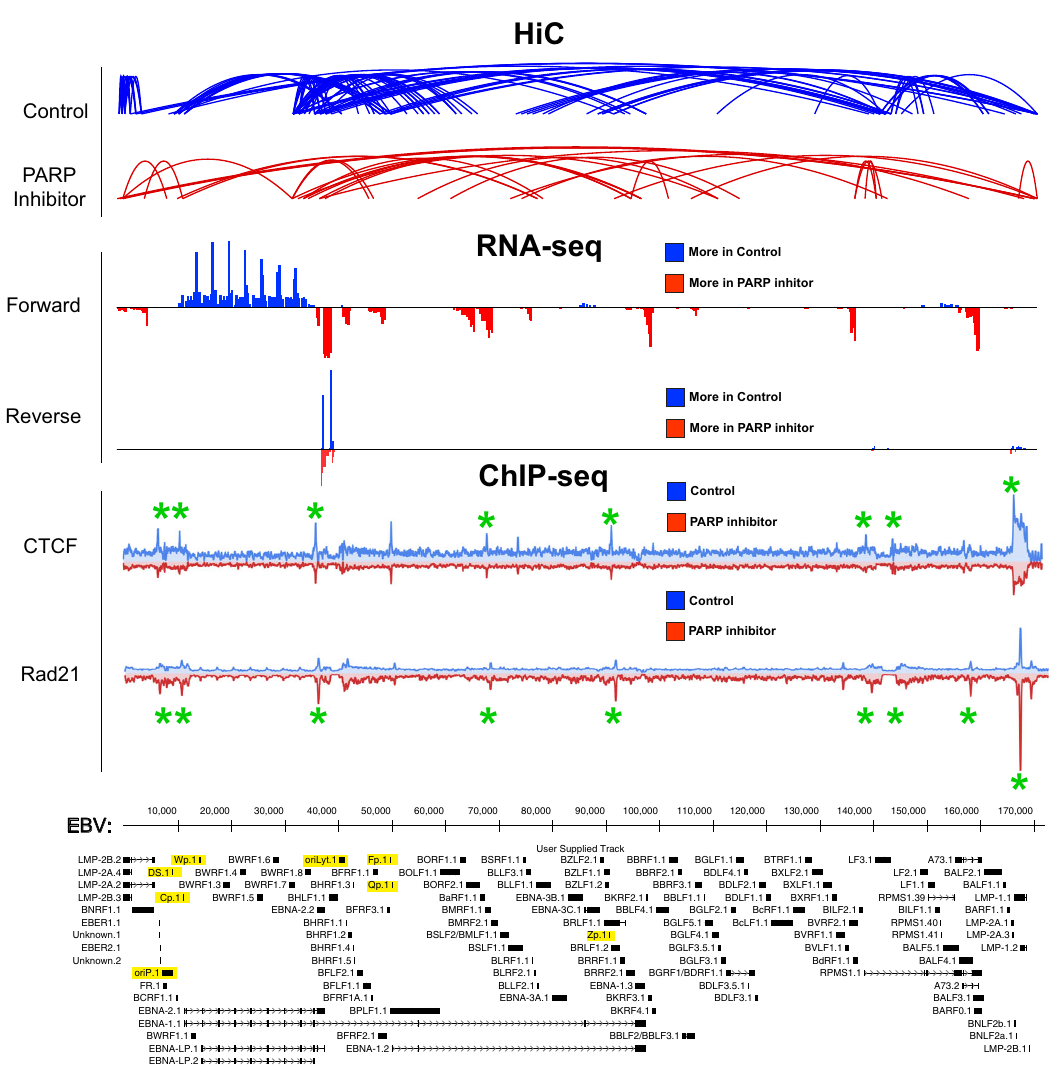
Fig. 4 HiC, ChIP-seq, and RNA-seq aligned datasets. The top panel “ HiC analysis ” aligns differences in chromatin looping between control and 2.5 µ M olaparib treated LCLs to the EBV genome. Blue arcs represent chromatin loops that are more frequent in the control genome, red arcs represent chromatin loops that are more frequently observed in the olaparib treated genome, and black arcs are loops that are unchanged between control and treatment. All arcs represent DNA-DNA interactions that occur at a statical signi fi cance of p < 0.05 from averaged biological duplicates. The middle panel “ RNA-seq ” displays RNA reads, forward and reverse, aligned to the EBV genome. Blue peaks pointing upward represent reads that occur more frequently in control LCLs while Red peaks pointing downwards represent reads occurring more frequently in olaparib treated LCLs. Genes with 2-fold change and q < 0.01 after correction for multiple testing (FDR) were considered as signi fi cantly differentially expressed. Bottom panel “ ChIP-seq ” aligns CTCF and cohesin (RAD21) tracks to the EBV genome, with and without PARP inhibition (2.5uM olaparib treatment for 72 h). The blue peaks pointing upwards represent regions of chromatin where CTCF or RAD21 binds more frequently in control samples while the red peaks pointing downwards represent regions where CTCFor RAD21 binds more frequently after PARP inhibition, respectively. Green stars represent peaks that were determined to be statistically signi fi cant binding sties via peak-calling. MACS2 software packages were used to call reads enrichment in pull-down samples compared to input samples as peaks. Analysis of peak distribution under differentiated conditions were performed with the bedtools software package for genome arithmetic. Data were visualized with LCLs, also have heightened RNA-seq reads that can be directly correlated to increased red arcs in the HiC data. The latent genes EBNA3B/3C conversely are under-expressed in olaparib treat- ment and align with chromatin binding events that are more frequent in the control genome. Finally, though the full-length RPMS1 transcript is downregulated in olaparib treated LCLs, there are a higher number of RNA reads as displayed by the red peak on the RNA-seq track (Fig. 4) that correlates with increased intragenomic contacts at the same RPMS1 transcript region.